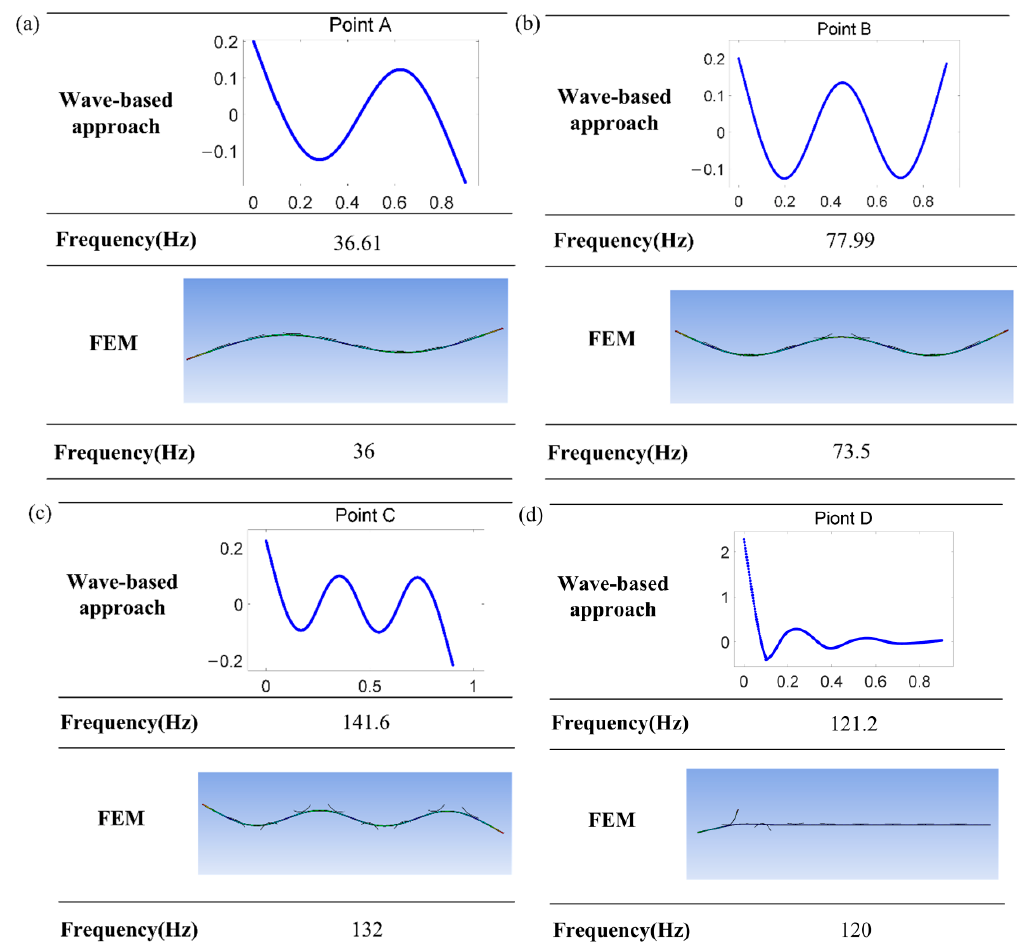
Figure 12. Steady-state vibration profiles obtained using the wave-based analysis approach and the FEM at the frequencies by the points ( a ) A, ( b ) B, ( c ) C, and ( d ) D in Figure 11a.